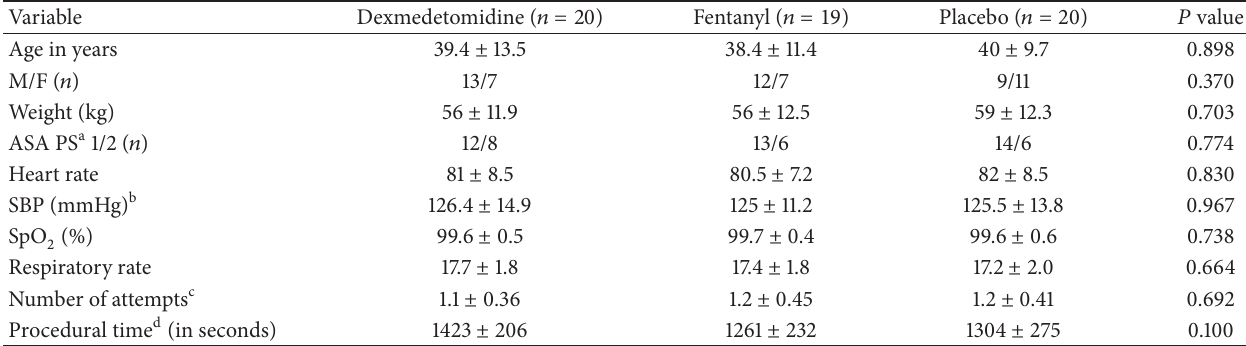
Table 1: Patients characteristics and baseline